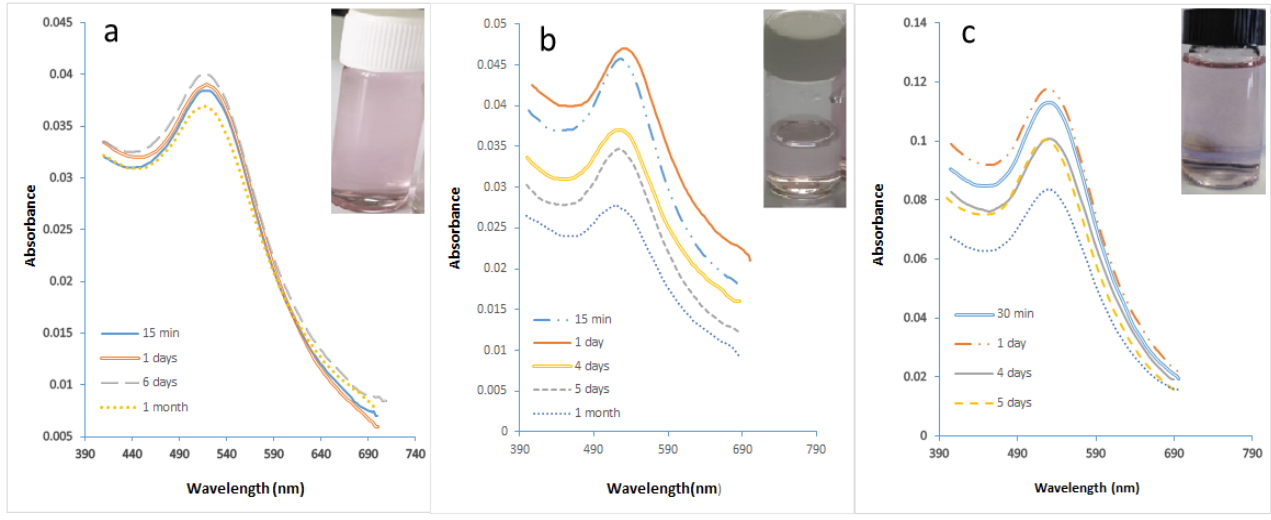
Figure 12. The ultraviolet (UV) spectra of GNP samples made in a microreactor at various temperatures. ( a ) at 291.15 K. ( b ) at 328.15 K. ( c ) The UV spectra for samples of GNPs that were conventionally prepared at 328.15 K. (Cons of SC, SB, and HAuCl 4 = 0.1 mM, total SB and gold flowrate with SC = 1.66 × 10 −5 L/s, volumetric ratio of SB/HAuCl 4 = 4:10, pH i = 3).